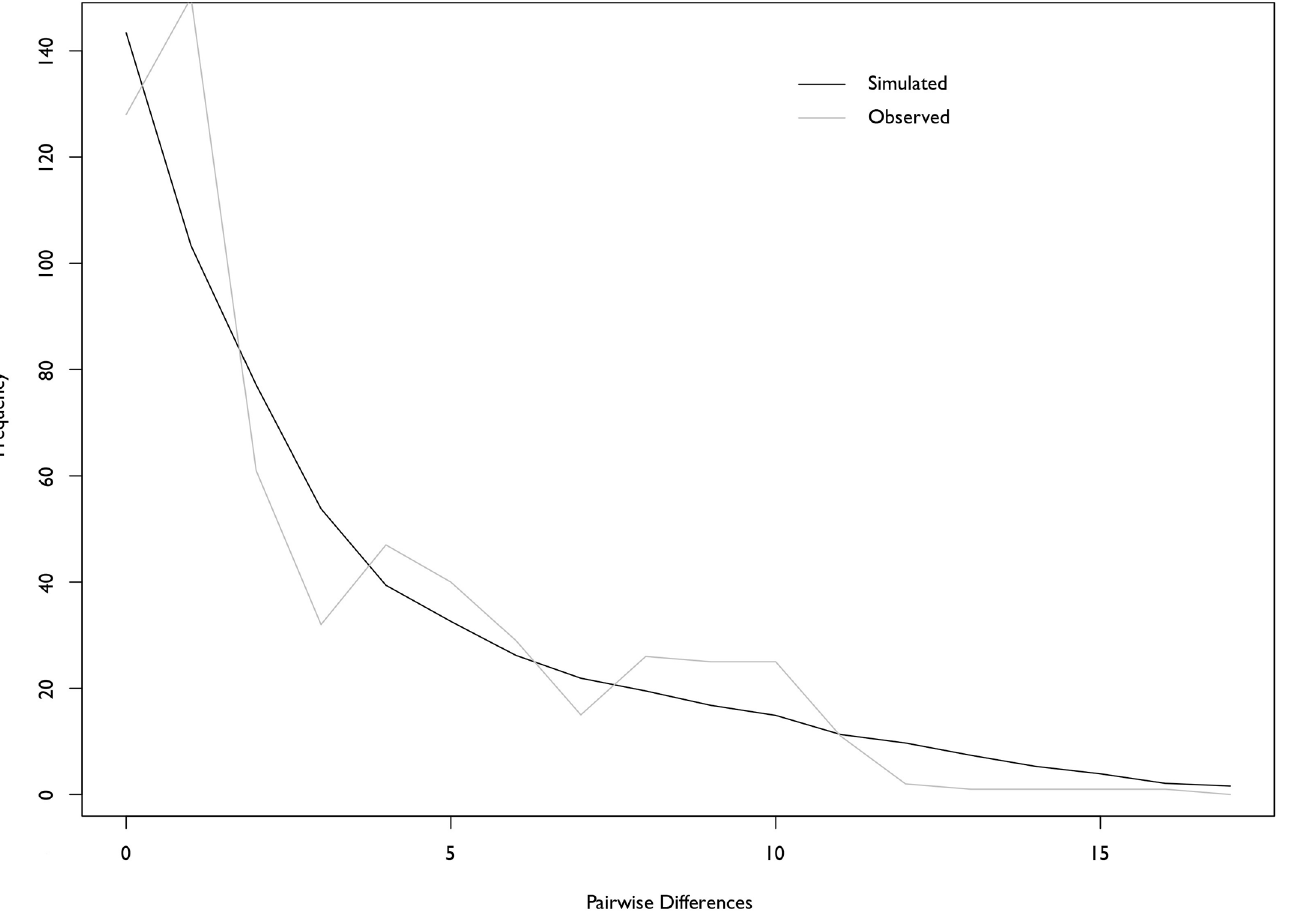
Fig 2. Mismatch distributions of pairwise nucleotide differences. Mismatch distributionsshoweda unimodal pattern and no significantdifferences betweenobserved and simulatedfrequencies.